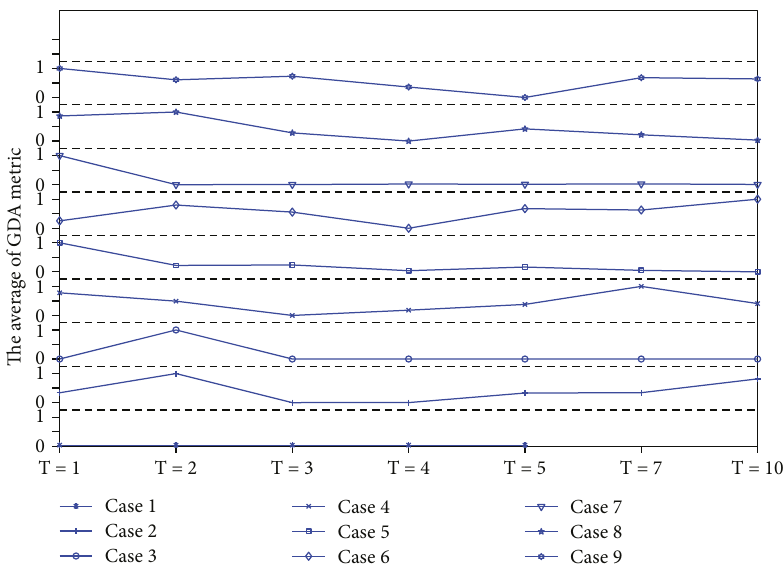
Figure 9: Results on di ff erent neighborhood list level of the average of GDA of the